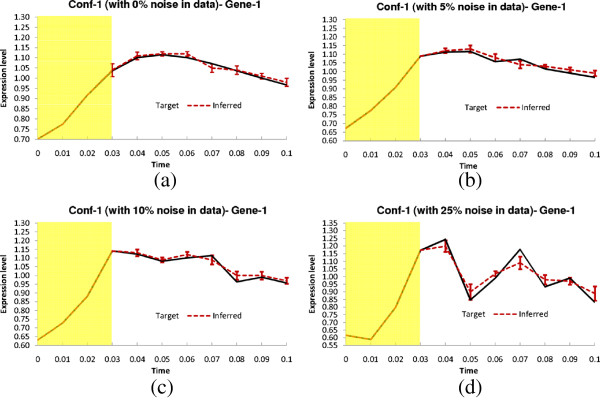
Dynamics for Gene-1 of Conf-1. Solid lines and dotted lines indicate respectively target and inferred (by TDSS) time-expressions in (a) Noise free data (b) 5% Noise in data (c) 10% Noise in data (d) 25% Noise in data. The yellow shaded region indicates the history information and the error bars indicate 95% confidence interval.